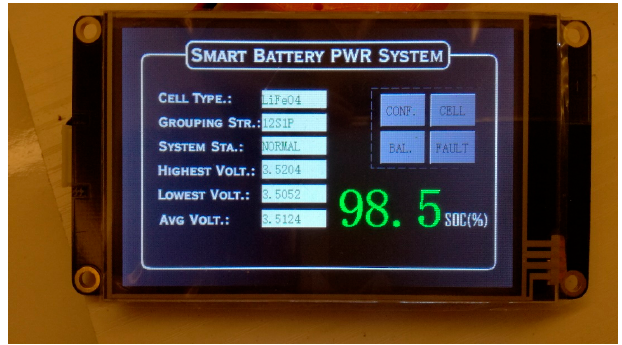
Figure 10. Front panel of GUI for proposed battery-power system. Energies 2017 , 10 , 1503